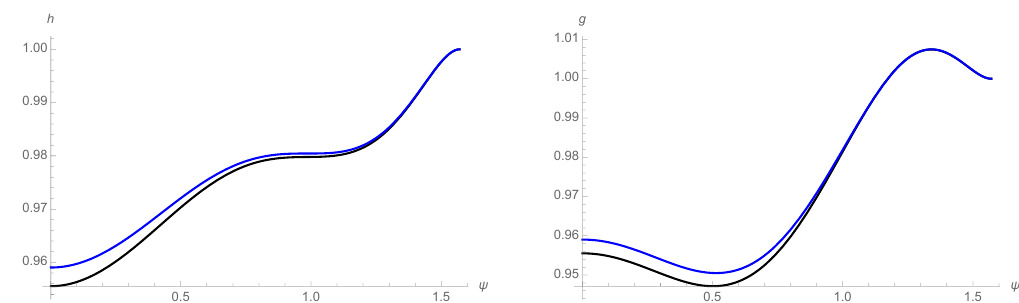
Figure 3 : Numerical solutions for the metric functions h ( ψ ) and g ( ψ ) are shown in black (the values e = 1 , α = 1 , L = 1 and G = 0 . 1 have been used). As a comparison, the H analytical approximations (2.27) are shown in